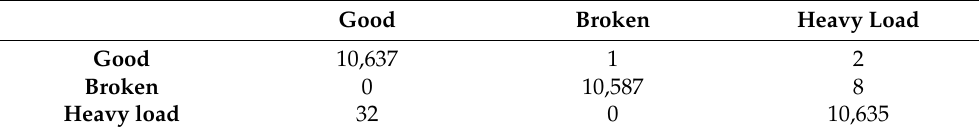
Table 3. Confusion matrix of the Keras CNN model for the implementation on STM tools. Good Broken Heavy Load Good 10,637